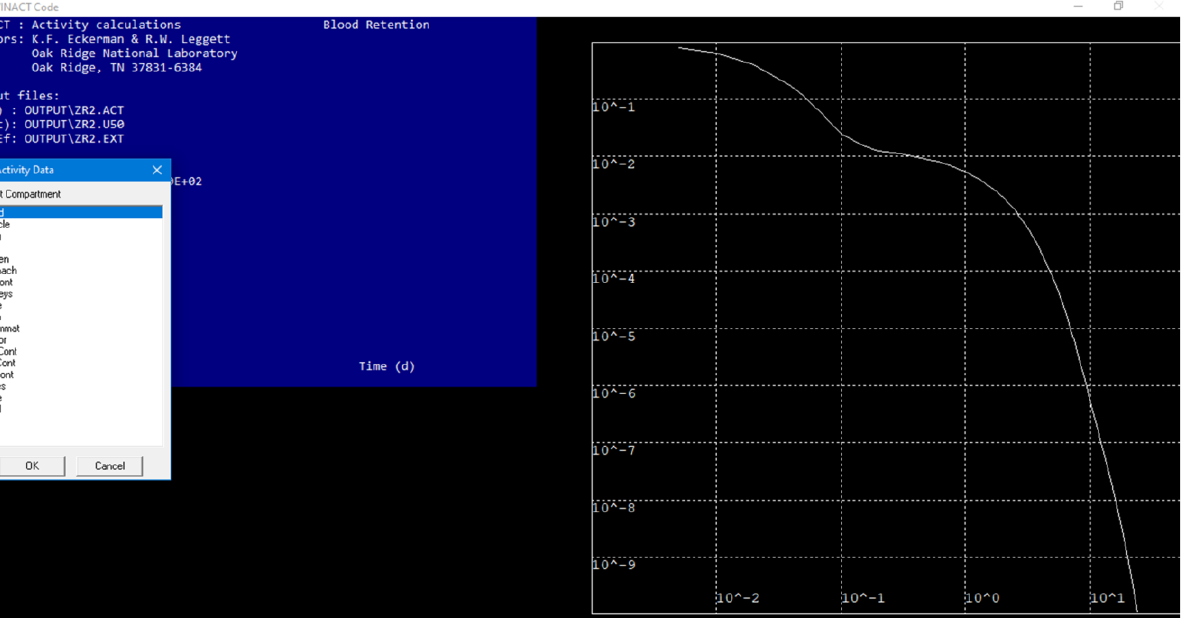
Figure 2. Transfer decay: an exponential function fitting estimated coefficients of transition from the organs to the blood and from the blood to the organs.